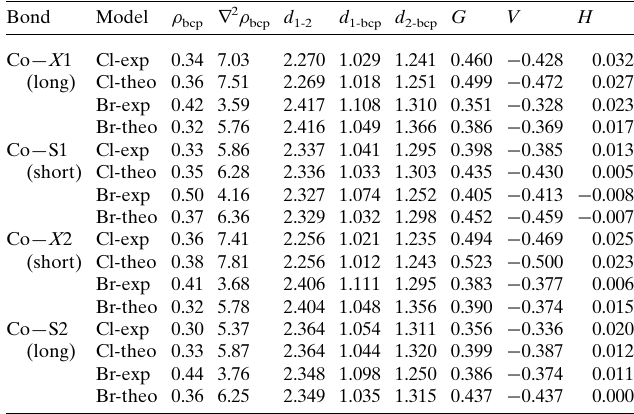
Table 4 d -orbital populations obtained from experimental multipole parameters for 1 and 2 . The values in parentheses are the percentage populations of the entire 3 d shell. Symmetry d -orbital